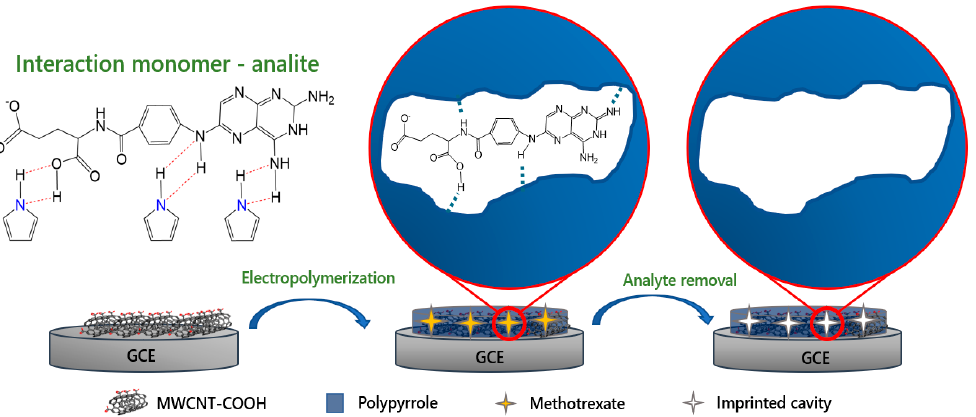
Figure 1. Schematic illustration of the preparation of electropolymerized MIP film and its applica- tion for the quantification of